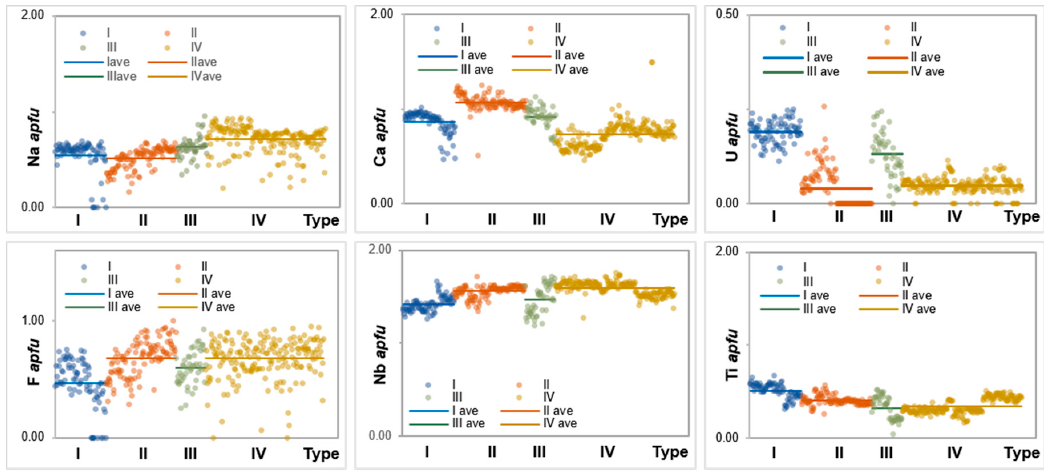
Figure 15. The apfu (atoms per formula unit) and its average values of the elements in pyrochlores I, II, III, and IV from the Huili area.